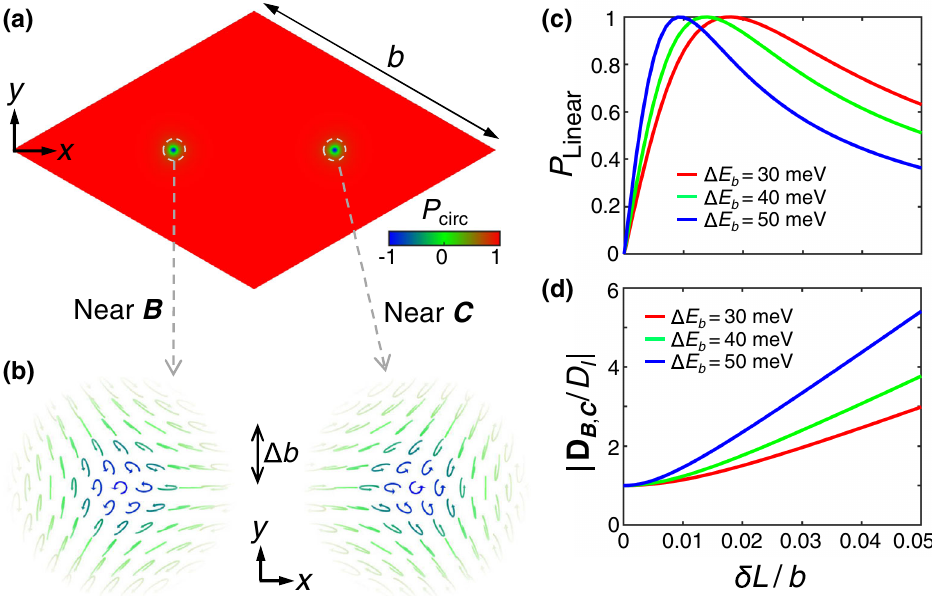
of the photon emission by the lowest-energy circ ¼ 1 over nearly the entire supercell, except the circ is due to the hybridization of X and X . (b) The enlarged view of circ inter intra when an linear j ; cf. Eq. (5)] also I